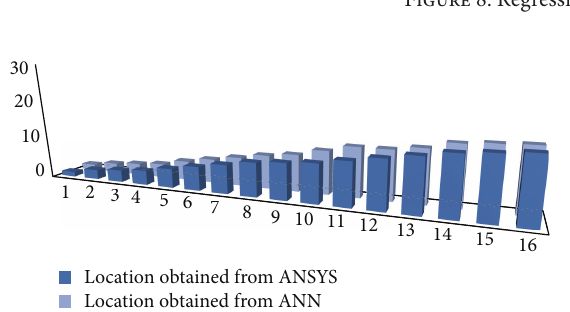
Figure 9: Comparison of result of location between ANSYS and